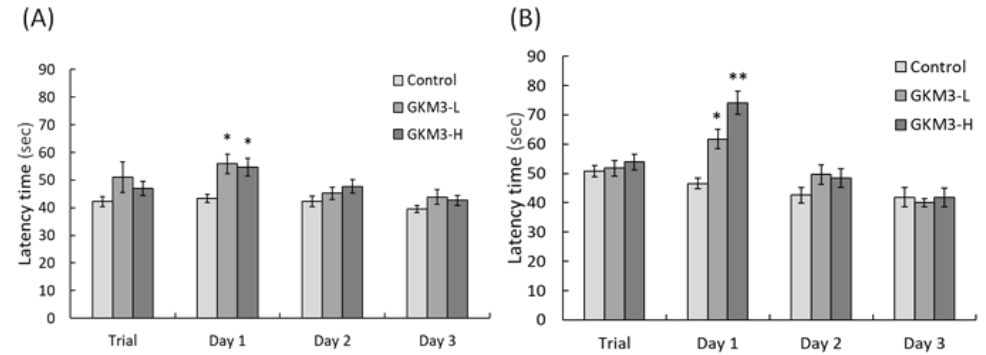
Figure 2. Passive avoidance ability of male ( A ) and female ( B ) SAMP8 mice. Values are presented as mean ± S.E.M. (n = 10). * p < 0.05 and ** p < 0.01 were regarded as a significant difference (one-way ANOVA). GKM3-L: 1.0 × 10 9 CFU/kg BW/day (low dose); GKM3-H: 5.1 × 10 9 CFU/kg BW/day (high dose).